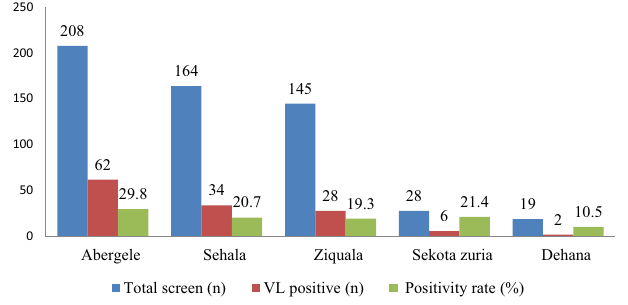
Figure 4. The geographical distribution of visceral leishmaniasis in the districts of Waghemra zone at Tefera Hailu Memorial Hospital, Sekota, Northeast Ethiopia from January 2017 to December 2021.